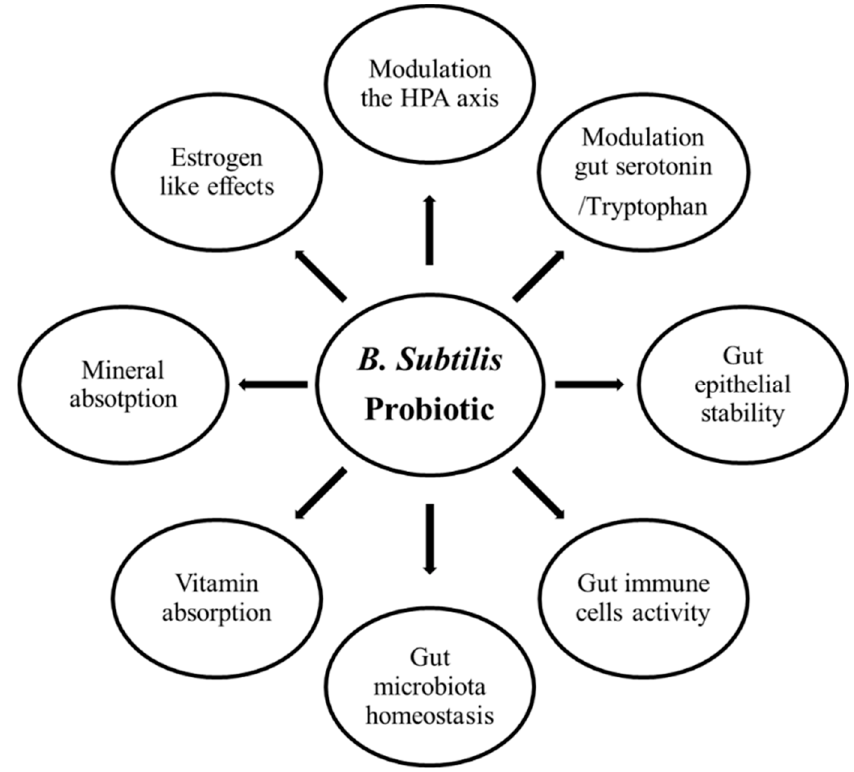
Figure 3. The schematic representation of the effects of B. subtilis -based probiotics on bone health via the microbiota–gut–brain axis, microbiota–gut–immune axis, and microbiota–gut–bone axis (modified from Amin et al. [188]).